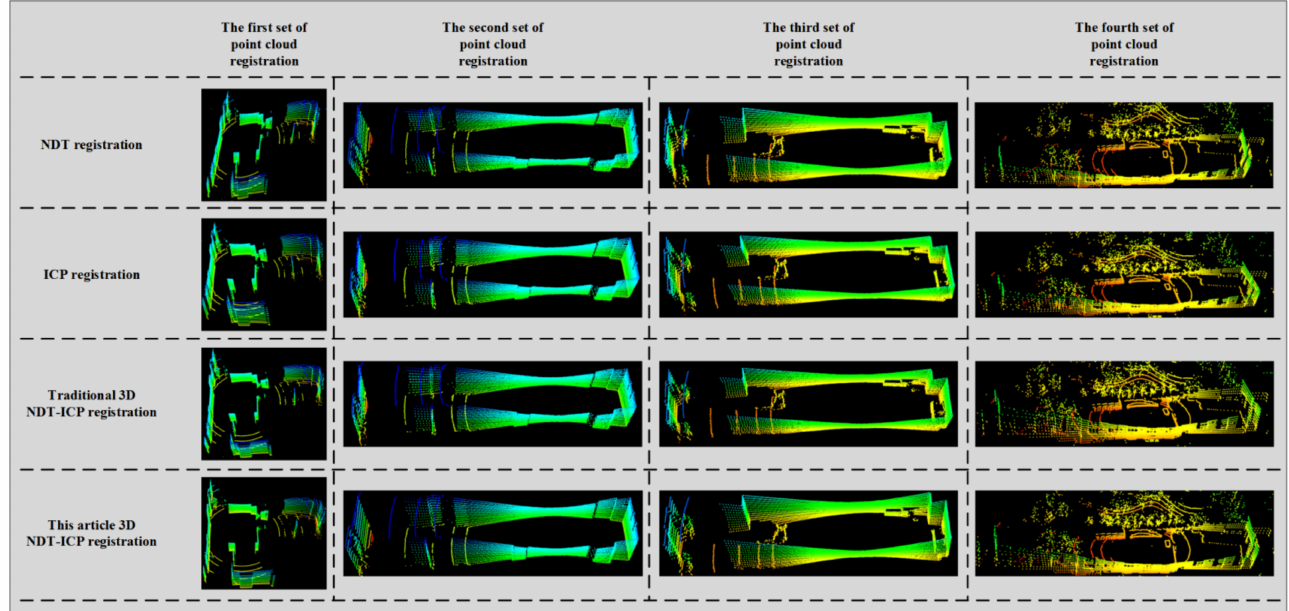
Figure 11. Final result of experimental point cloud